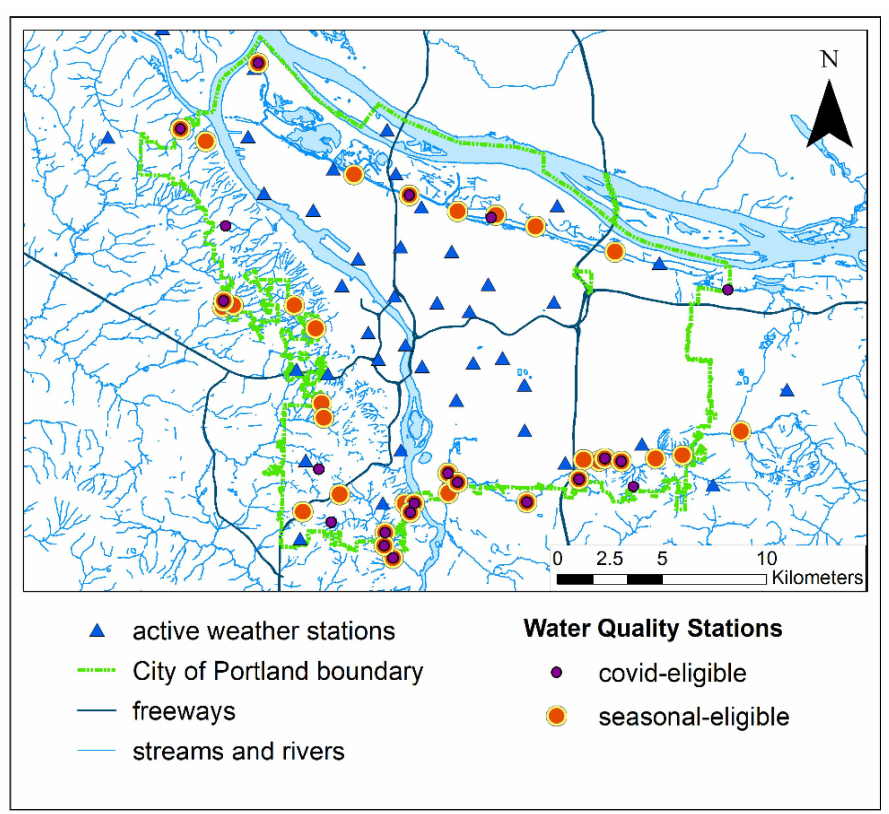
Figure 1. Study area: the city limits and locations of water quality monitoring and weather stations in Portland, OR,